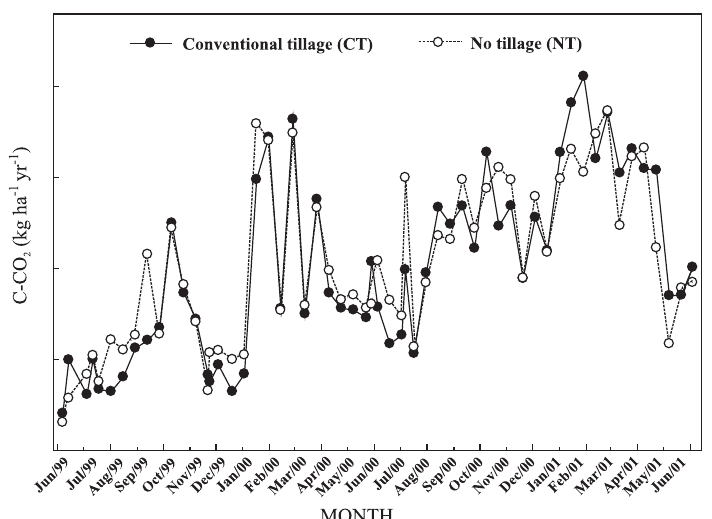
Figure 5. Monthly average peaks of C-CO between June 7, 1999 and June 4,